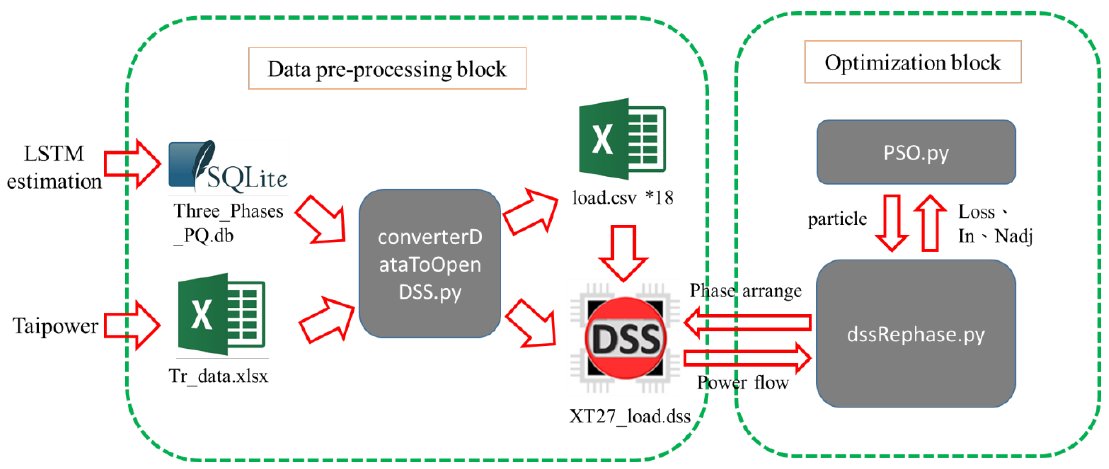
Figure 3. The structure of optimal phase arrangement.